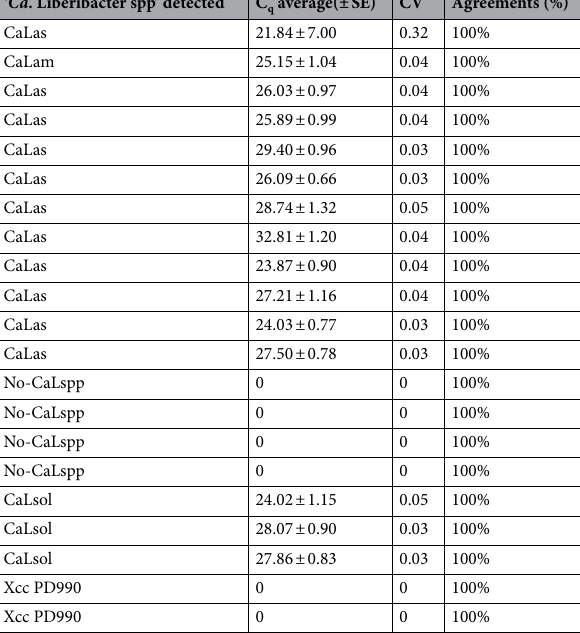
Table 2. Results obtained in the Test Performing Study (TPS 2020 HLB) organized by the European Union Reference Laboratory Plant Health for pests of plants on bacteria, showing the average C q values, the standard error, the coefficient of variation and agreements obtained by six laboratories